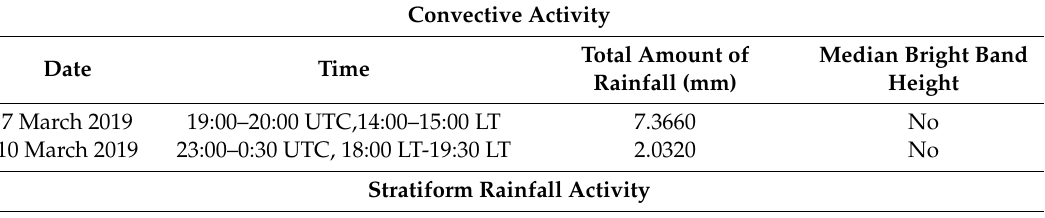
Table 4. Time of occurrences, accumulated rainfall and bright band height during the convective and stratiform rainfall events during the campaign periods.